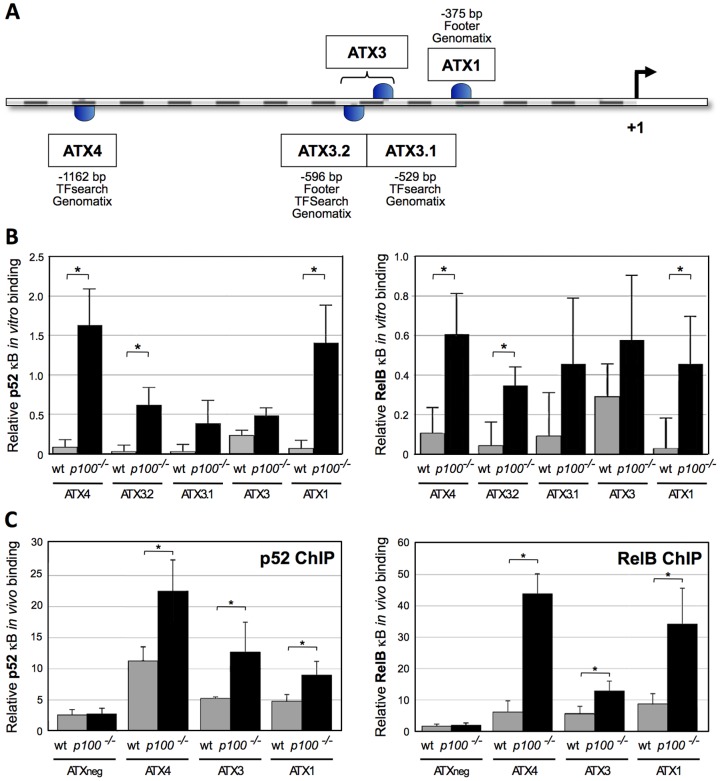
Lack of p100 results in enhanced p52 and RelB binding to NF-κB target sites in the Enpp2/Atx promoter.(A) Schematic view of the Enpp2/Atx promoter. In silico analysis of the Enpp2/Atx promoter (−2485 bp upstream of the ATG codon) with MatInspector and TFSearch softwares revealed four potential NF-κB sites: ATX4 at position −1162 (CGGGGGCTTC), ATX3.2 at position −596 (GGAAGCTCCC), ATX3.1 at position −529 (AGGGTCATTCC), and ATX1 at position −375 (GGGAAATTCT). ATX3.2 and ATX1 κB target site have been previously described using the software Footer [30]. (B) In vitro binding of p52 and RelB to κB target sites in the Enpp2/Atx promoter was determined by the TransAM Flexi NF-κB Family Transcription Factor Assay (Active Motif). Three independent experiments were performed. Data are presented as mean values ± SD. Statistically significant differences are indicated by * (Student's t-test, P≤0.05). (C) In vivo binding of p52 and RelB to κB target sites in the Enpp2/Atx promoter. An unrelated site (ATXneg) served as a negative control. For ChIP experiments, the Express Magnetic Chromatin Immunoprecipitation Kit (Active Motif) was employed according to the manufacturer's instructions. ChIP assays for RNA polymerase II binding to the Gapdh promoter were used for normalization as input control. Data are presented as mean values ± SD, n = 3. Statistically significant differences are indicated by * (Student's t-test, P≤0.05).